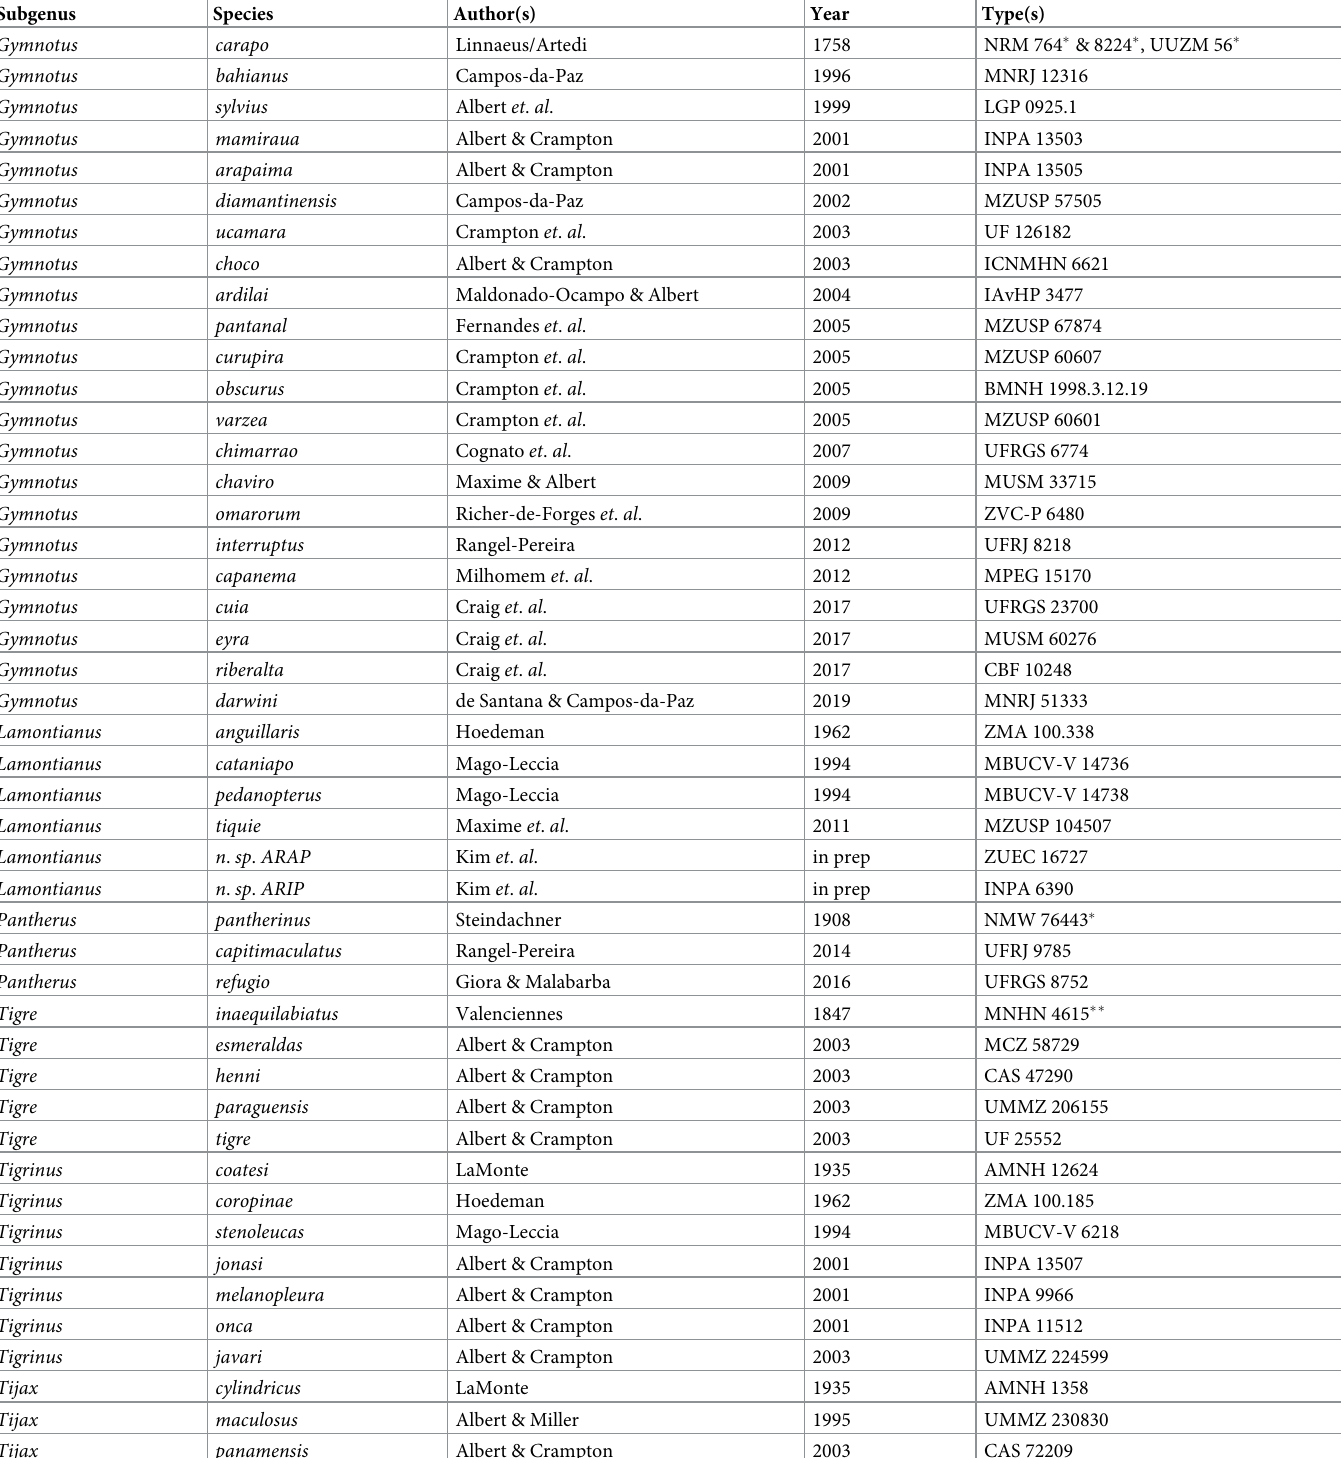
Table 1. List of the 43 valid and two undescribed gymnotine species, their name–bearing types (asterisks denote syntypes, double asterisks denote neotypes, all oth- ers are holotypes) and the geographic coordinates and localities of these type localities.